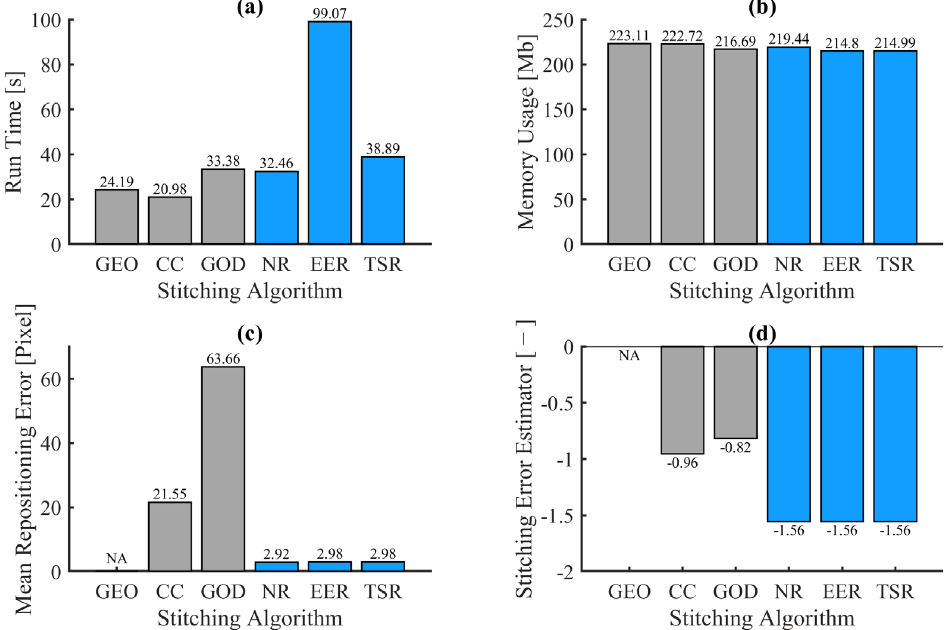
Figure 15. Bar charts of the quantitative criteria for test case D: run time ( a ), memory usage ( b ), mean repositioning error ( c ) and stitching error estimator ( d ). NA = Not Applicable.